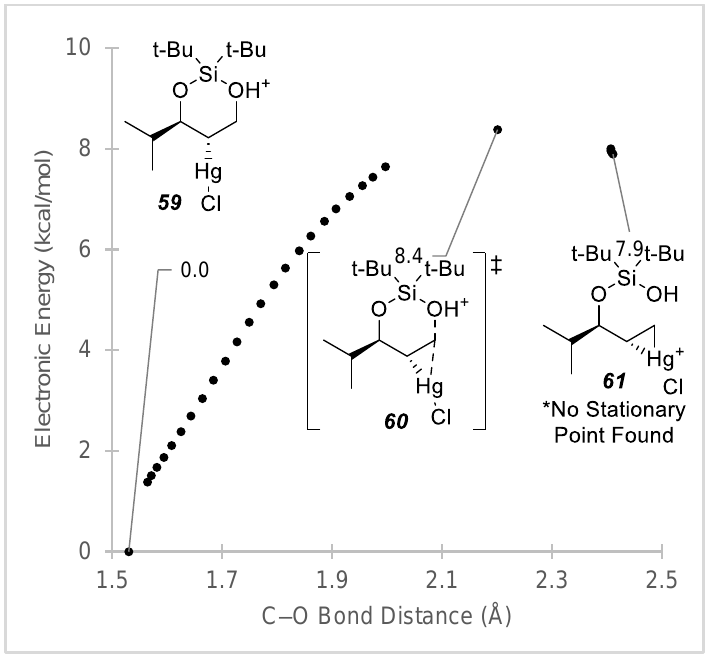
Figure 3. Mercuronium rearrangement of isopropyl substrate 4 (IRC calculation from the transition state).